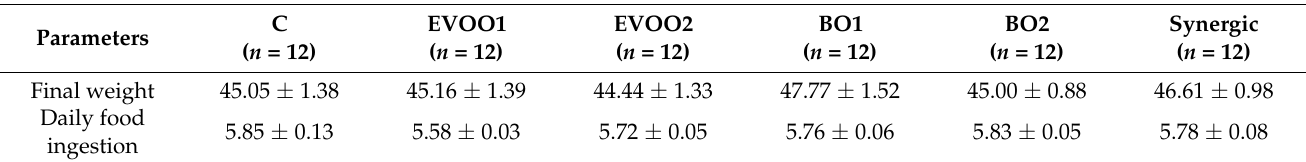
Table 6. Final weight (g) of the animals after 90 days of supplementation and mean daily food ingestion (g/day).